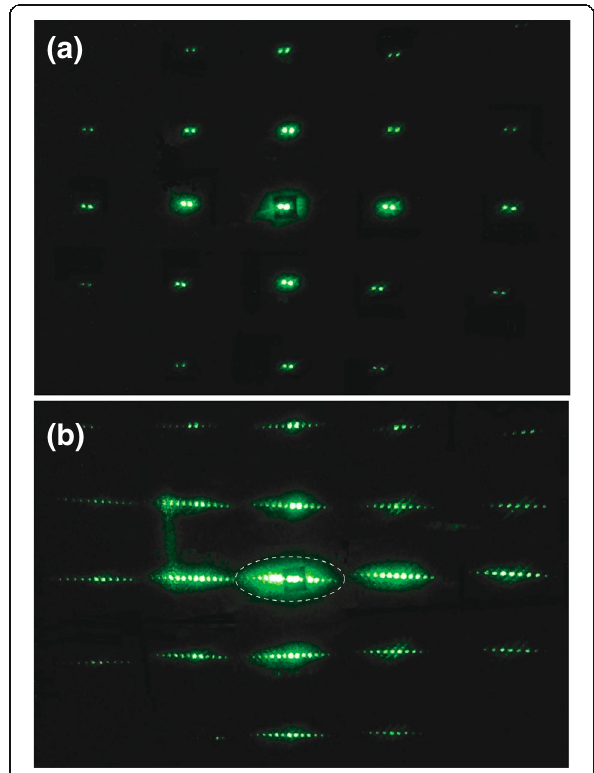
Fig. 5 Typical patterns of scattering for two interfering laser beams formed by hybrid nonlinear LC cell with microstructured surface. a Scattering pattern of a hybrid cell without applied electric field. b Formation of many diffraction orders (the Raman-Nath self-diffraction) at application of DC electric voltage. The centre line is shown